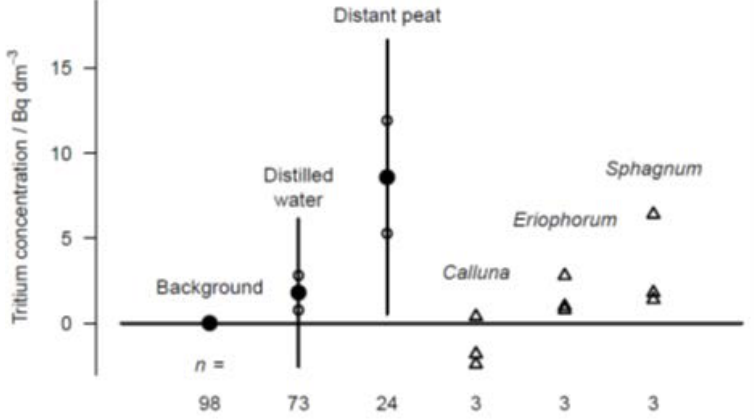
Figure 7. Concentration of tritium in water in various low-activity samples. Filled circle is mean; ‘whiskers’ show ± 1 SD; small unfilled circles show 95 % confidence limits. (For ‘Background’ the limits are inside the symbol.) ‘Distant peat’ was collected from various sites, all at least 500 m from the experiment. There were only three samples of each of the most abundant plants, collected 100 cm downslope from injection sites. Note that the tritium concentrations are as Bq dm -3 , but in later Figures are Bq cm -3 .